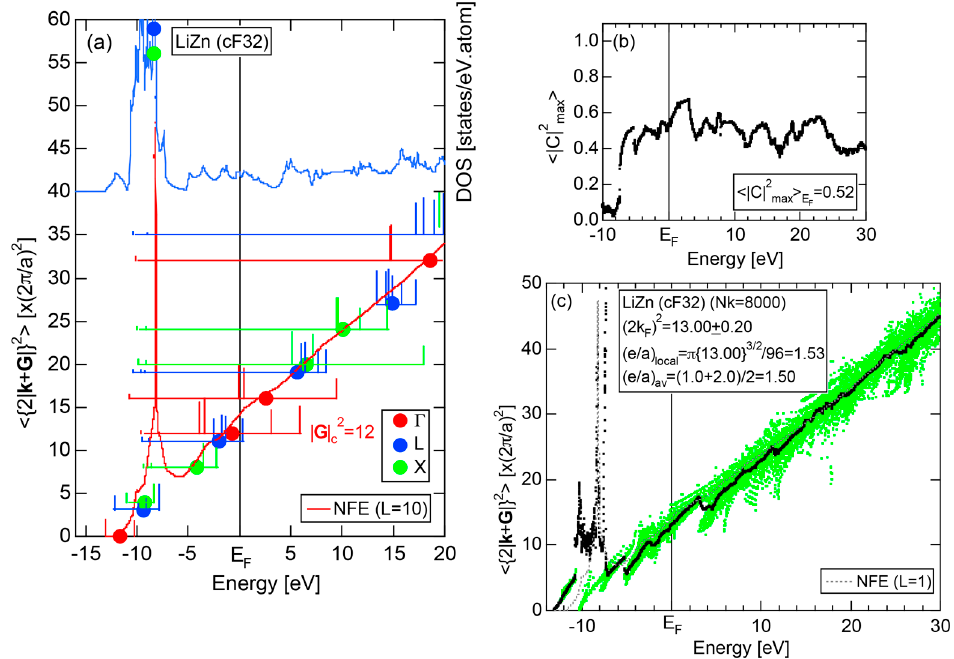
Figure 63. ( a ) FLAPW-Fourier spectra at symmetry points Γ , L, X of the fcc Brillouin zone along with the total DOS; ( b ) C and ( c ) Hume-Rothery plot for LiZn (cF32) [11,41]. See captions of Figure 19 (b) for symbols in ( c ).